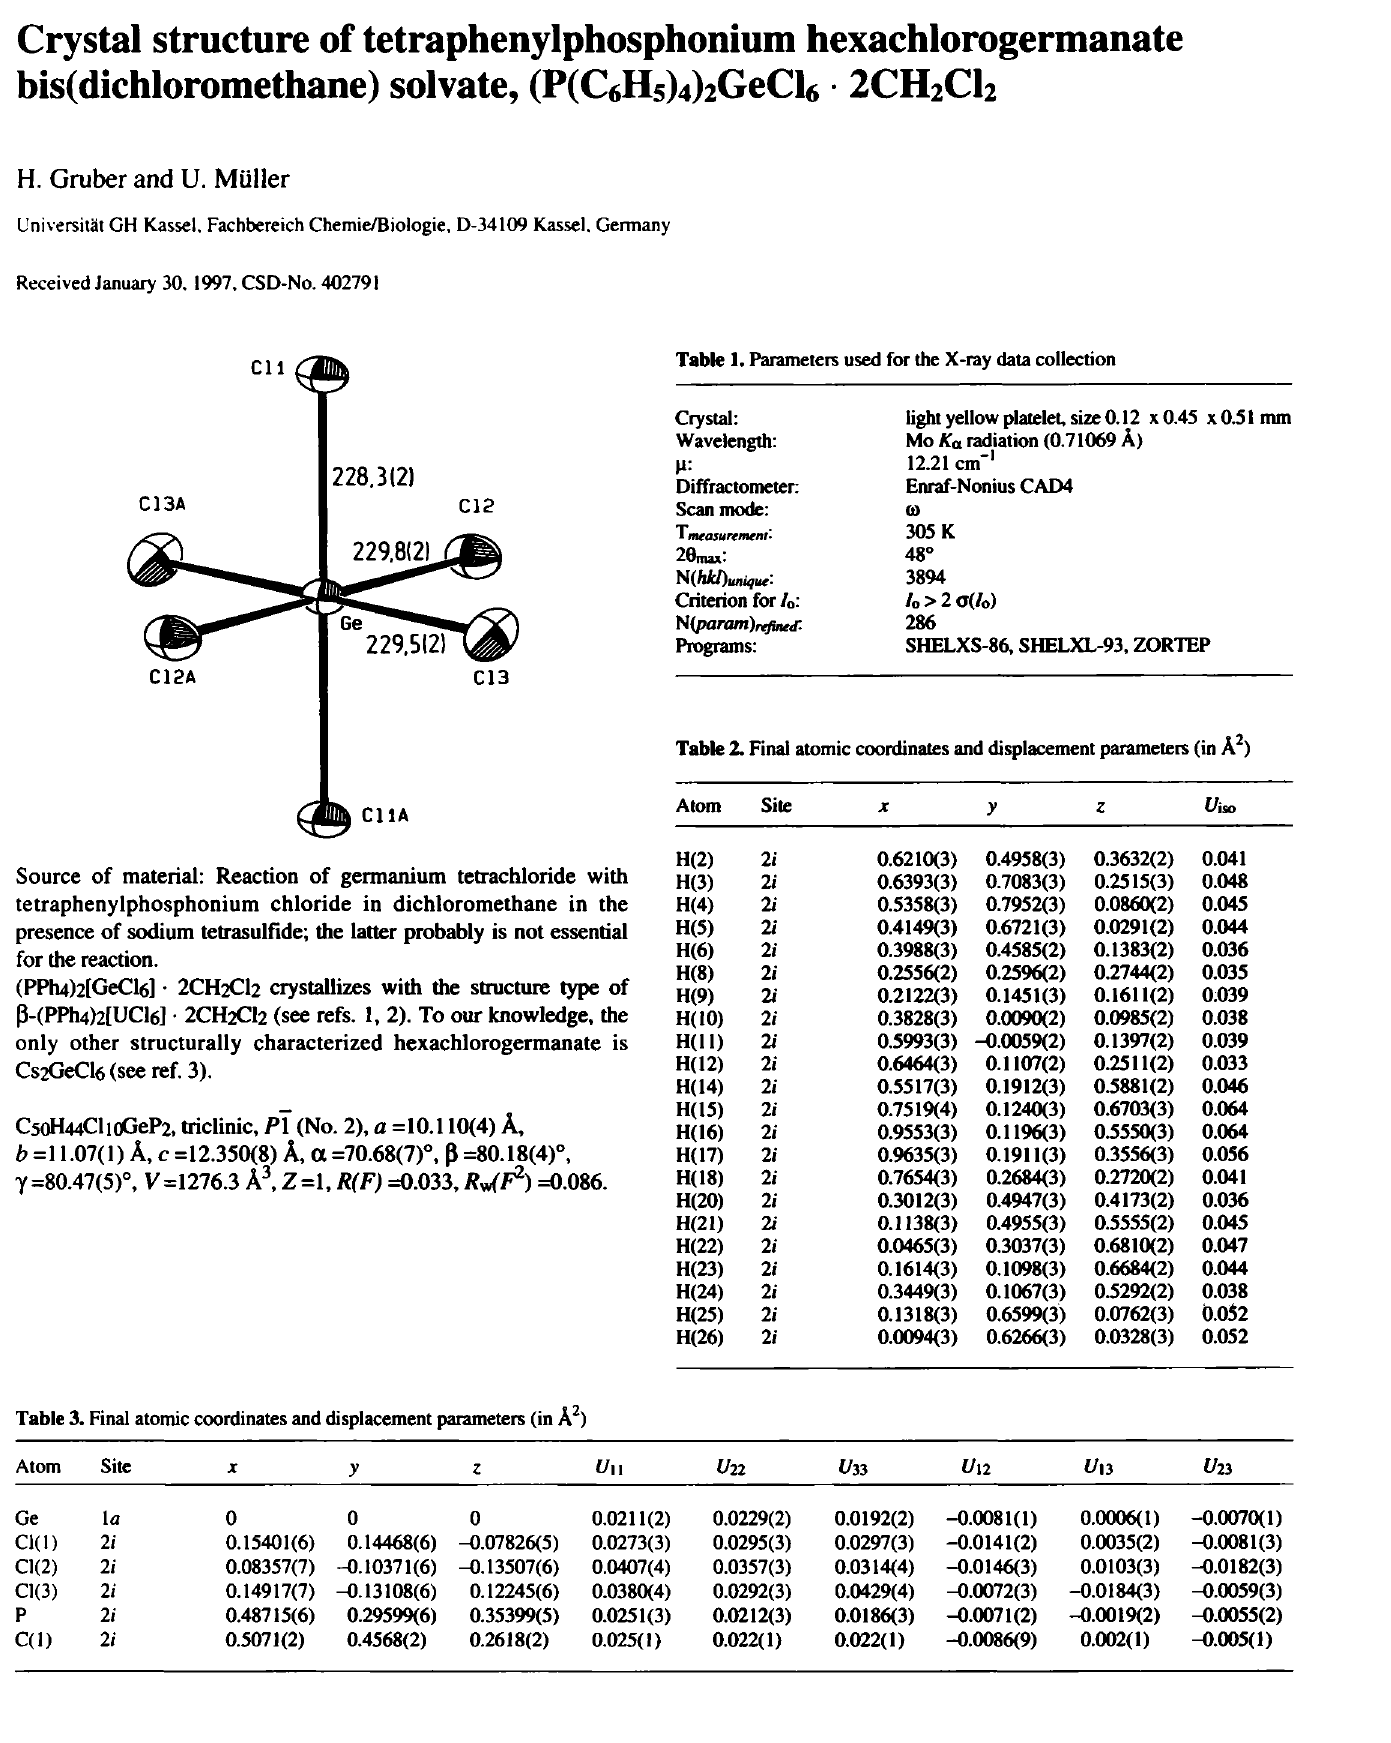
Table 1. Parameters used for the X-ray data collection Crystal: